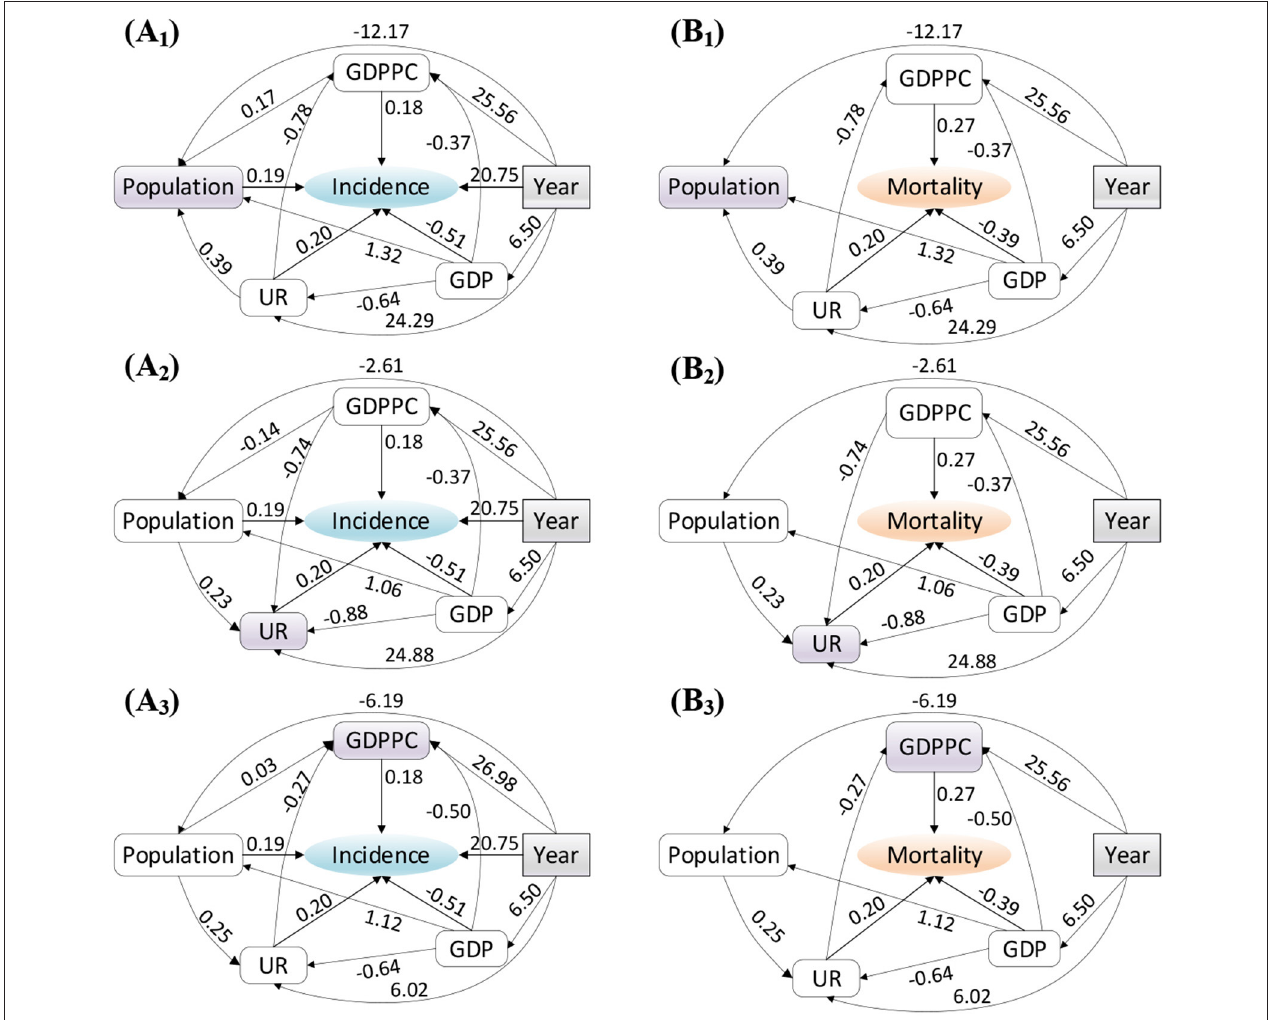
FIGURE 1 | Structural equations model used to illustrate the relation between the (A) incidence and (B) mortality rates and socioeconomic factors. Among many variables, subscripts are used to represent high-order variables, of which subscript 1, 2, and 3 correspond to high-order variables population, UR and GDPPC